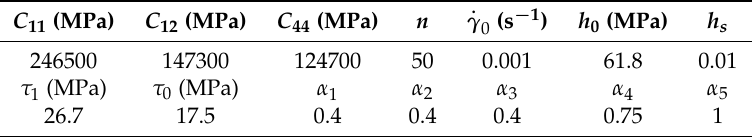
Figure 1. CPFE model of HPT [35]. ( a ) Configuration of the sample and the initial orientation; ( b ) meshes of the sample. Table 1. Parameters in the hardening law.